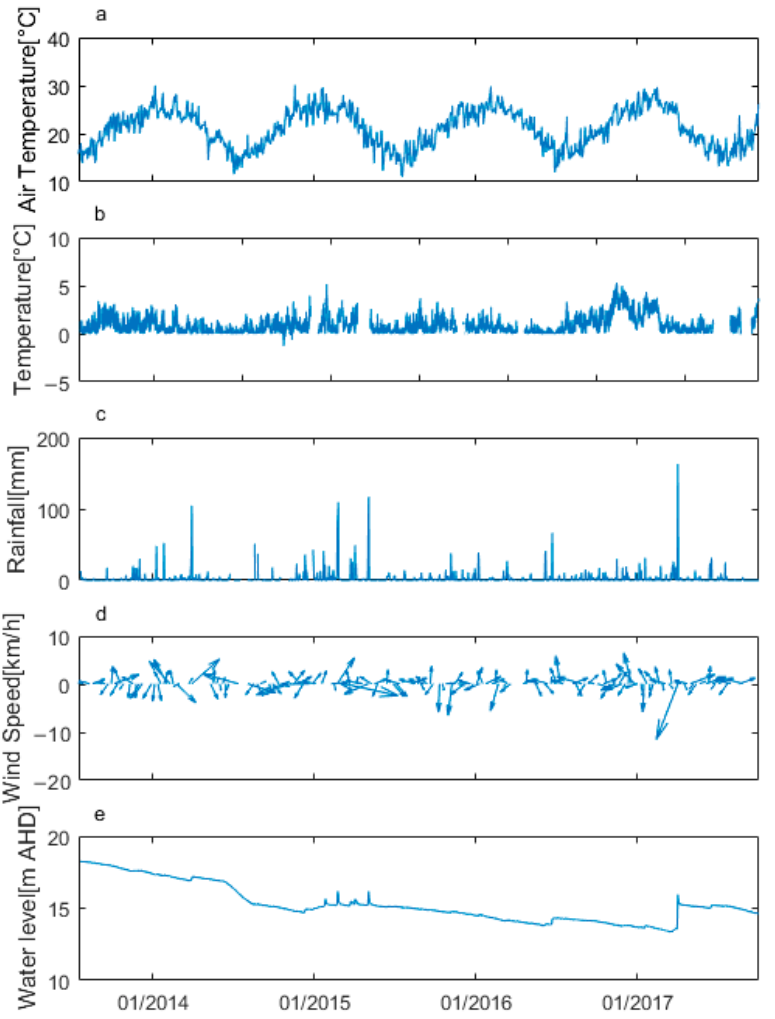
Figure 2. Time series of: ( a ) Daily air temperature; ( b ) hourly column water temperature differential between depths of 1 m and 10 m; ( c ) daily rainfall; ( d ) weekly wind condition and ( e ) daily water level in Tingalpa Reservoir from 2013 to 2017.